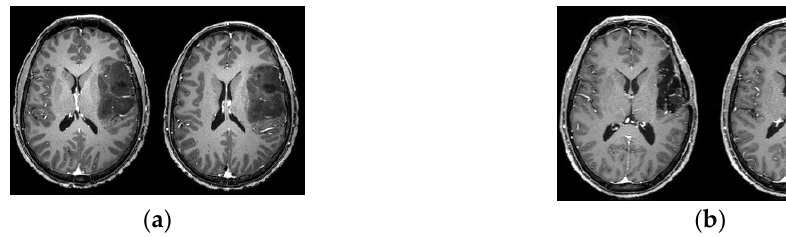
Figure 2. Axial view T1-weighted MRI. Upper image shows frontotemporoinsular glioma before first surgery. ( a ) Lower images show recurrence before second surgery. ( b ) Recurrent neoplastic tissue was located both along the walls of and within the previous-tumor cavity.